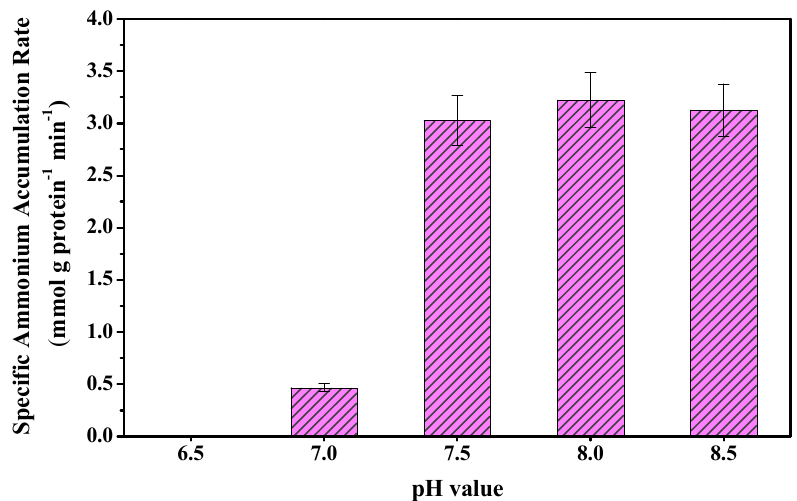
Figure 7. Effect of pH on the maximum Specific Ammonium Accumulation Rate (mmol g protein − 1 min − 1 ) upon addition of 250 mg NH 4+ -N L − 1 . Incubation conditions included temperature of 25 °C, initial NH 4+ -N concentration of 250 mg N L − 1 , and cell density of 500 mg TSS L − 1 , equivalent to 1.29 × 10 9 cells mL − 1 .